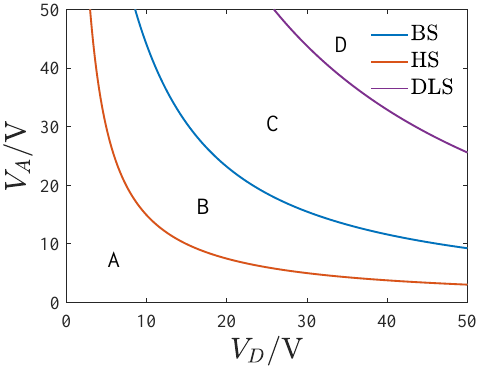
Figure 12. The transition sets on the DC-AC voltage plane with θ = 0, where BS denotes the bifurcation set, HS denotes the hysteresis set, and DLS is the double limit point set. Figure 14 shows the amplitude–frequency curves in the driving direction correspond- ing to different parameter regions. For clarity, the physical amplitudes are used instead of the non-dimensional amplitudes, where A d = A 1 x 0 and A s = A 2 x 0 . The numerical results of the Runge–Kutta method are also given. They indicate that the jump phenomenon does not occur in region A. For region B, the response jumps down at point a as the frequency increases and jumps up at point b when the frequency decreases. In region C, the response pulls in after it jumps up with the frequency increase. Furthermore, the response jumps to another solution curve when the frequency is reduced. In region D, the jump of the re- sponse at both the frequency’s increasing and its decreasing leads to pull-in. The open-loop gyroscope cannot work stably in multi-solution regions because it may result in an incorrect output as the system is disturbed. Note that the peak parts of the amplitude–frequency curves of regions C and D are included in the multi-solution region. Furthermore, pull-in may occur with the change in the frequency. Thus, only regions A and B are feasible for the gyroscope